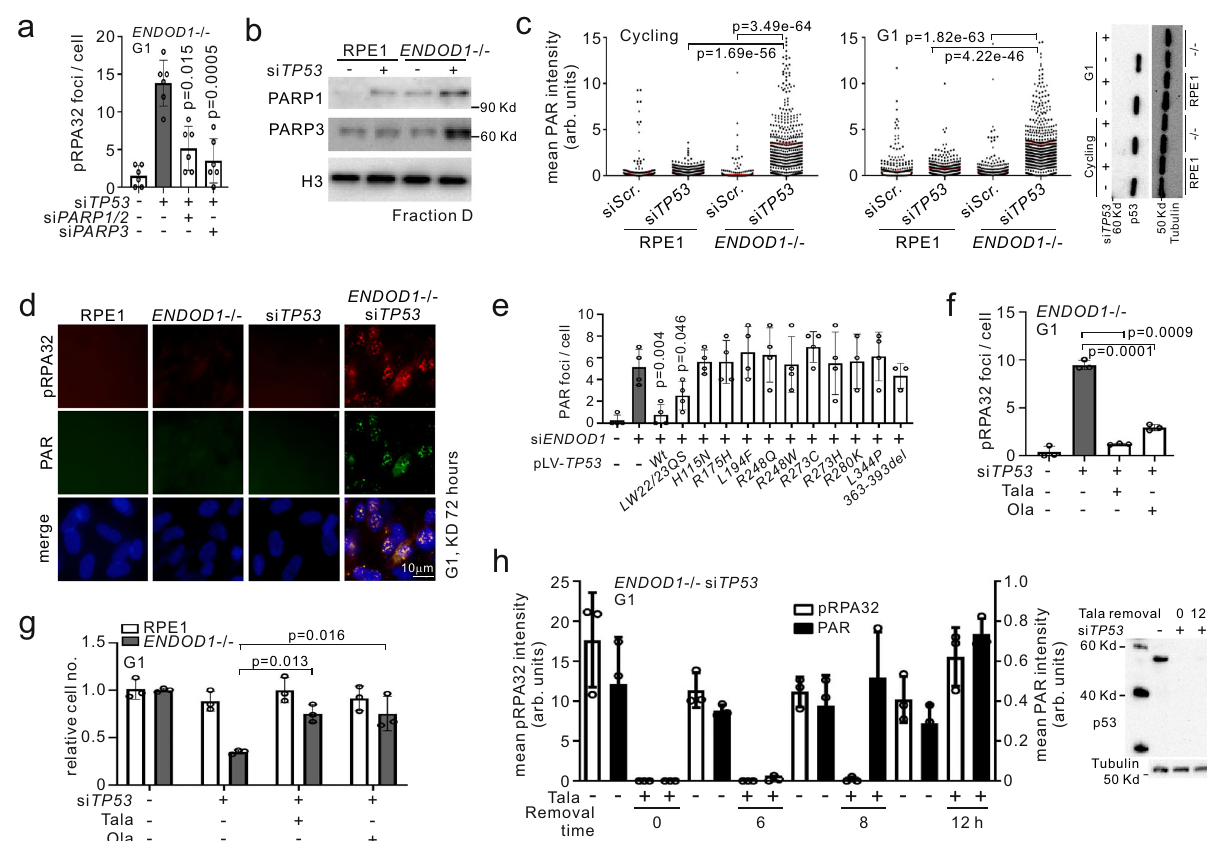
Fig. 5 PARP activity is required for the SL between ENDOD1 and TP53 . a pRPA32 foci in serum starved ENDOD1 − / − cells treated with the speci fi